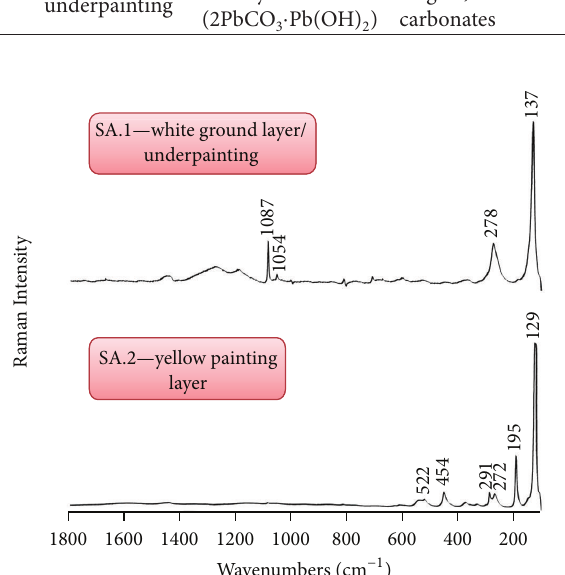
Figure 4: Micro-Raman spectra of the cross-section layers of “Al- legory of Wealth”